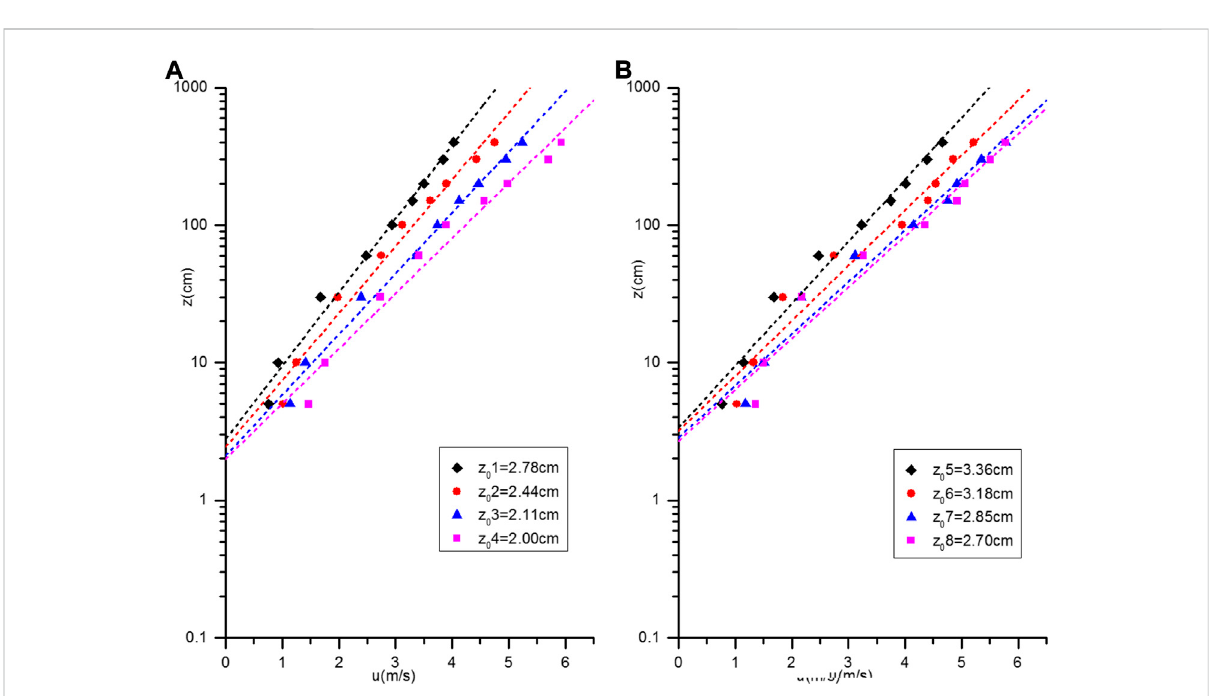
FIGURE 4 Windpro fi lesofthe Artemisiaordosica communityonsandylandundernon-sand-drivingwind[ (A) Semi- fi xedsandyland; (B)